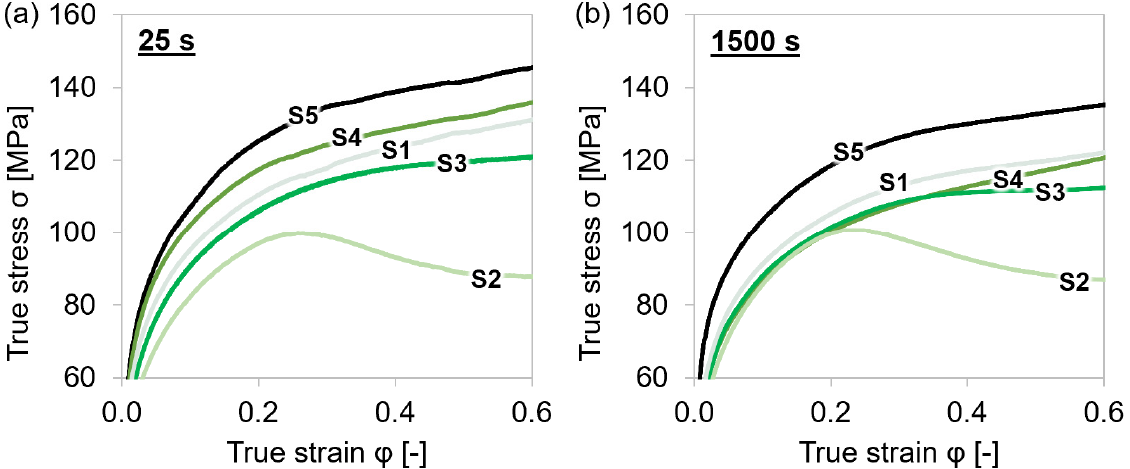
Figure 4. Stress–strain curves during single-hit compression tests with varying holding times before deformation and 0.01 s − 1 strain rate at 1153 K for MA steel grades S1–S5. ( a ) 25 s; ( b ) 1500 s. Except for S2, the true stresses of the materials reached higher values after shorter holding at the test temperature. This result can be explained by the impact of microalloy carbonitrides on strengthening and is discussed in detail in Section 4.4.3.